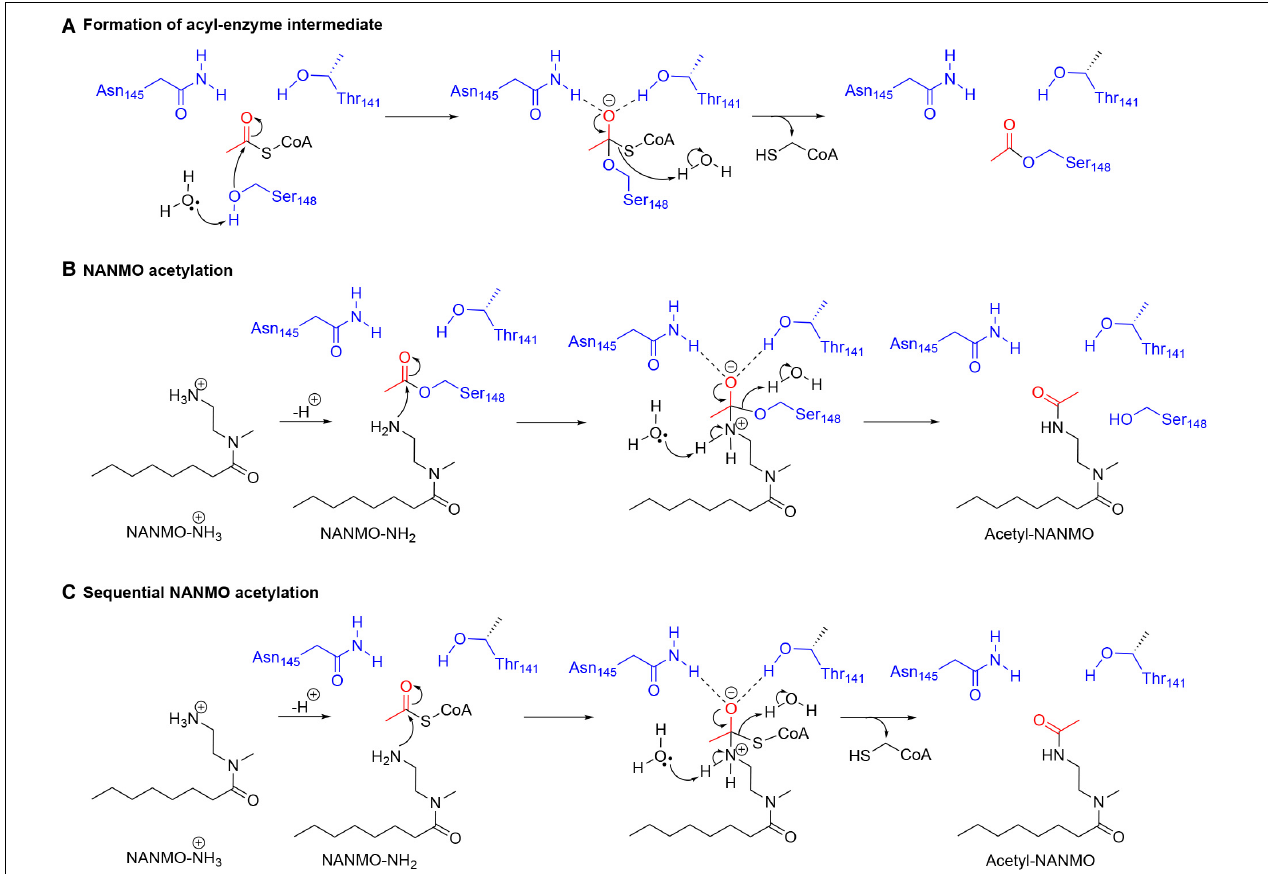
FIGURE 8 | Proposed chemical mechanism for PA3944 using both ping-pong and sequential components of the hybrid mechanism. In the ping-pong component, (A) S148 acts as a nucleophile and is acetylated during the enzymatic reaction and then (B) deprotonated NANMO is acetylated by the acyl enzyme. In the sequential component, (C) direct enzyme-mediated acetylation of NANMO by AcCoA